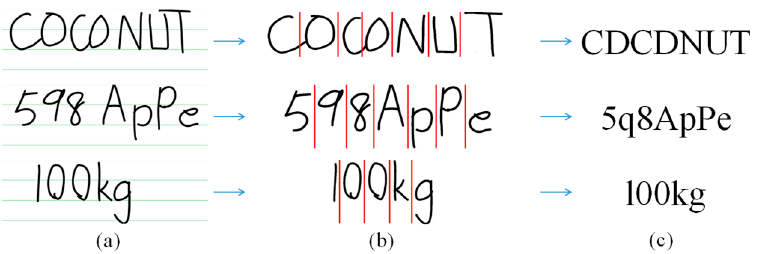
Figure 18. Some images of incorrect recognition results: ( a ) Images input into the system, ( b ) images with segmentation lines, and ( c ) recognition results.